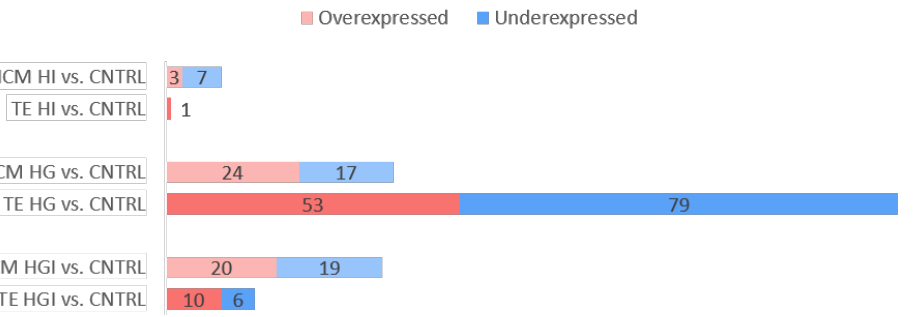
Figure 3. Differentially expressed genes (DEG) in ICM and TE of in vitro-developed blastocysts with HI, HG, or HGI compared to CNTRL. The number of overexpressed (red) and underexpressed (blue) DEGs with p -adjusted < 0.05 are shown. ICM, inner cell mass. TE, trophectoderm.